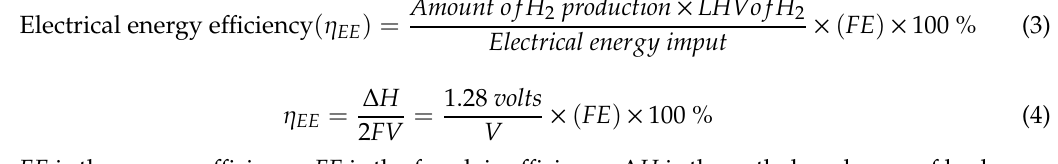
Figure S1: X-ray di ff raction patterns of commercial SZCY541 and BZCY(54) 8 / 9 2 powders from KUSAKA RARE METAL PRODUCTS Co., LTD, Kanagawa, Japan. Figure S2: SEM morphology of BZCY(54) 8 / 9 2 powders (a) Purchased powder from KUSAKA RARE METAL PRODUCTS Co., LTD, Kanagawa, Japan, as calcined at 1200 ◦ C (b) In house synthesized after calcination at 1300 ◦ C and milling, FS3: XRD patterns of green NiO-BZCY(54) 8 / 9 2 electrode substrate and after sintering at 1350 and 1450 ◦ C, Video S1: Shape evolution and bending behavior of the half-cell during